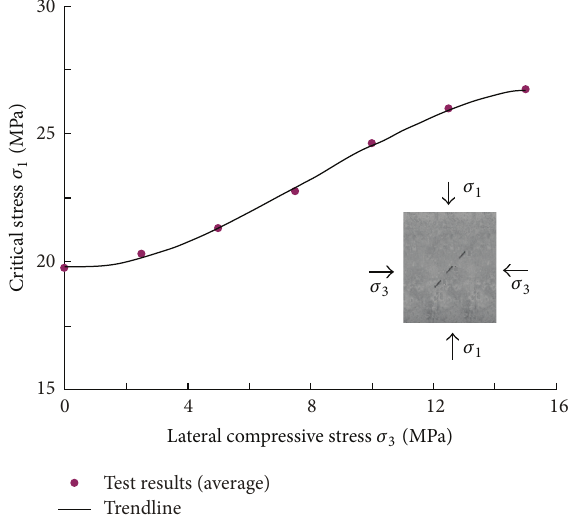
Figure 4: Relation of critical stress 𝜎 1 versus the confining stress 𝜎 3 ( 𝜎 2 is kept as a constant).